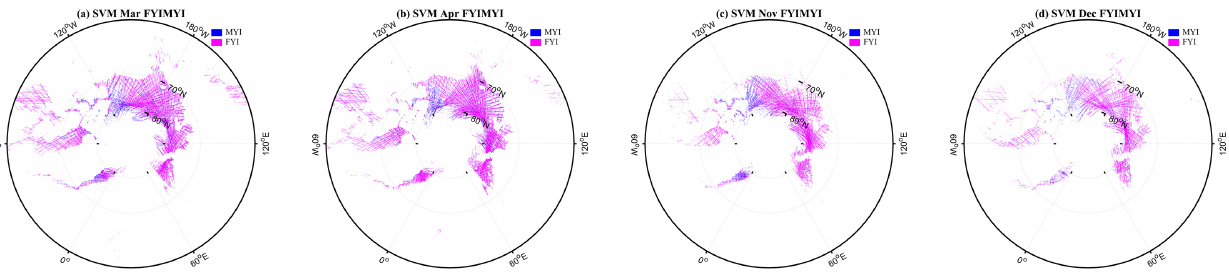
Figure A15. RF for FYI-MYI classification using the data in December as the training set. The data in ( a ) February, ( b ) March, ( c ) April, and ( d ) November are used as the test set in turn.